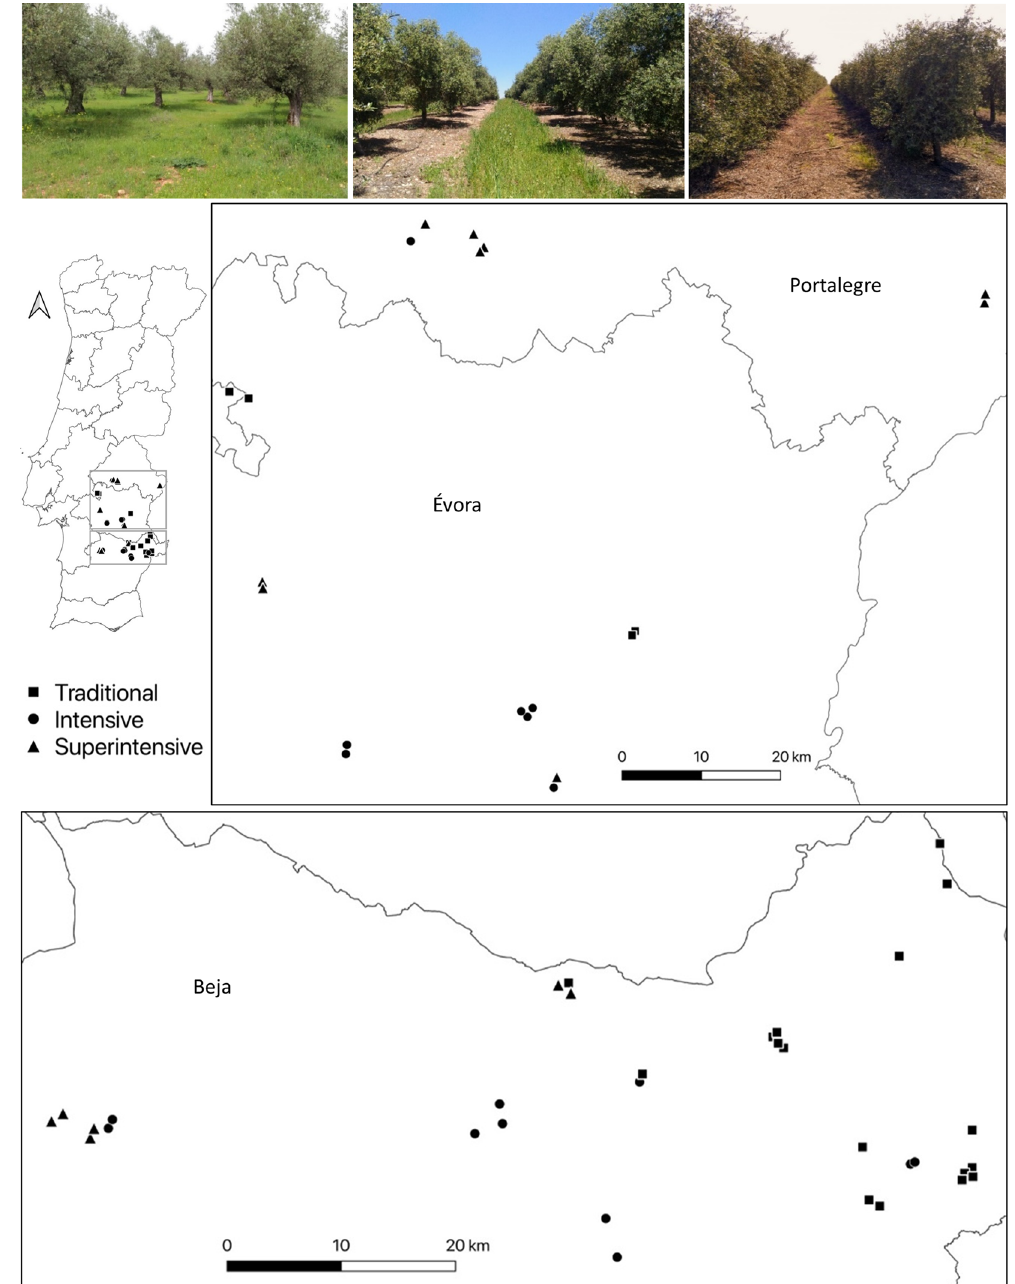
Figure 1. Location of the 53 points sampled for canopy-dwelling arthropods in traditional, intensive and superintensive orchards across the Alentejo region, southern Portugal. The two inset maps show the northern and southern sections of the study area in detail. Along the top are photographs representing traditional (left), intensive (middle) and superintensive (right) orchards. The maps were generated using the free and open source Geographic Information System QGIS v3.10 (https:// qgis. org/ en/